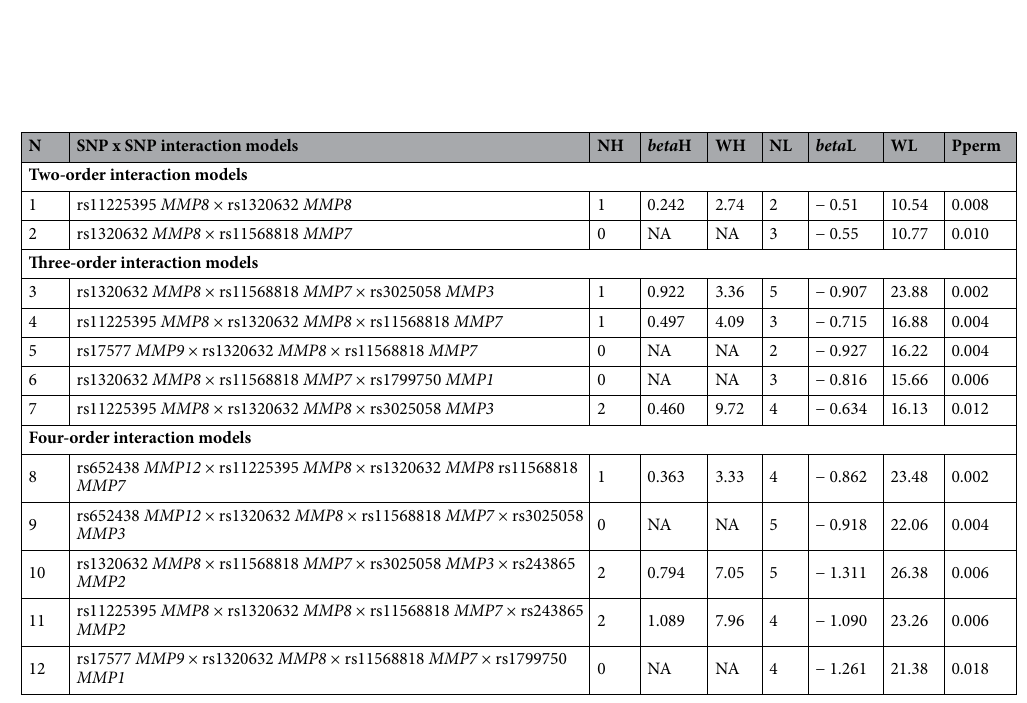
Table 4. Gene–gene interactions significantly associated with the risk of EH according to MB-MDR. NH , number of significant High risk genotypes in the interaction, beta H , regression coefficient for High